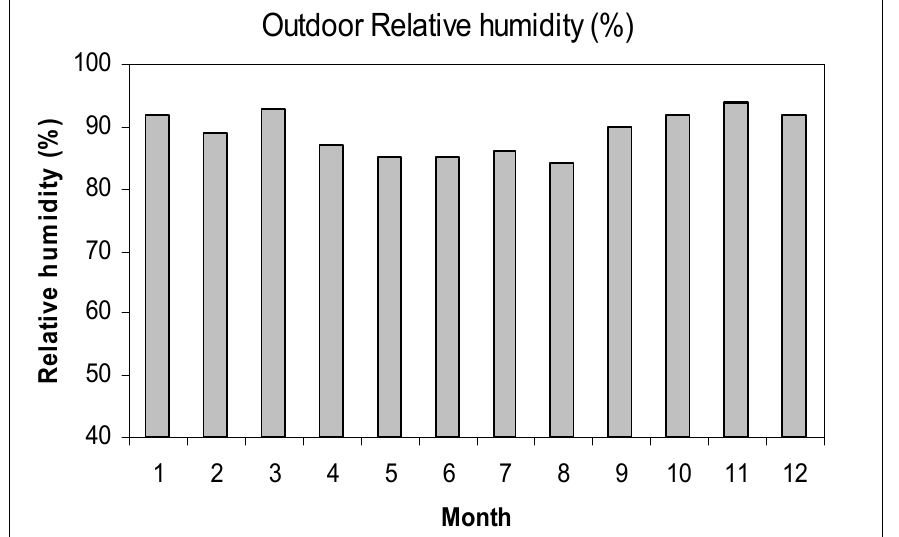
Figure 4. Outdoor relative humidity (%).